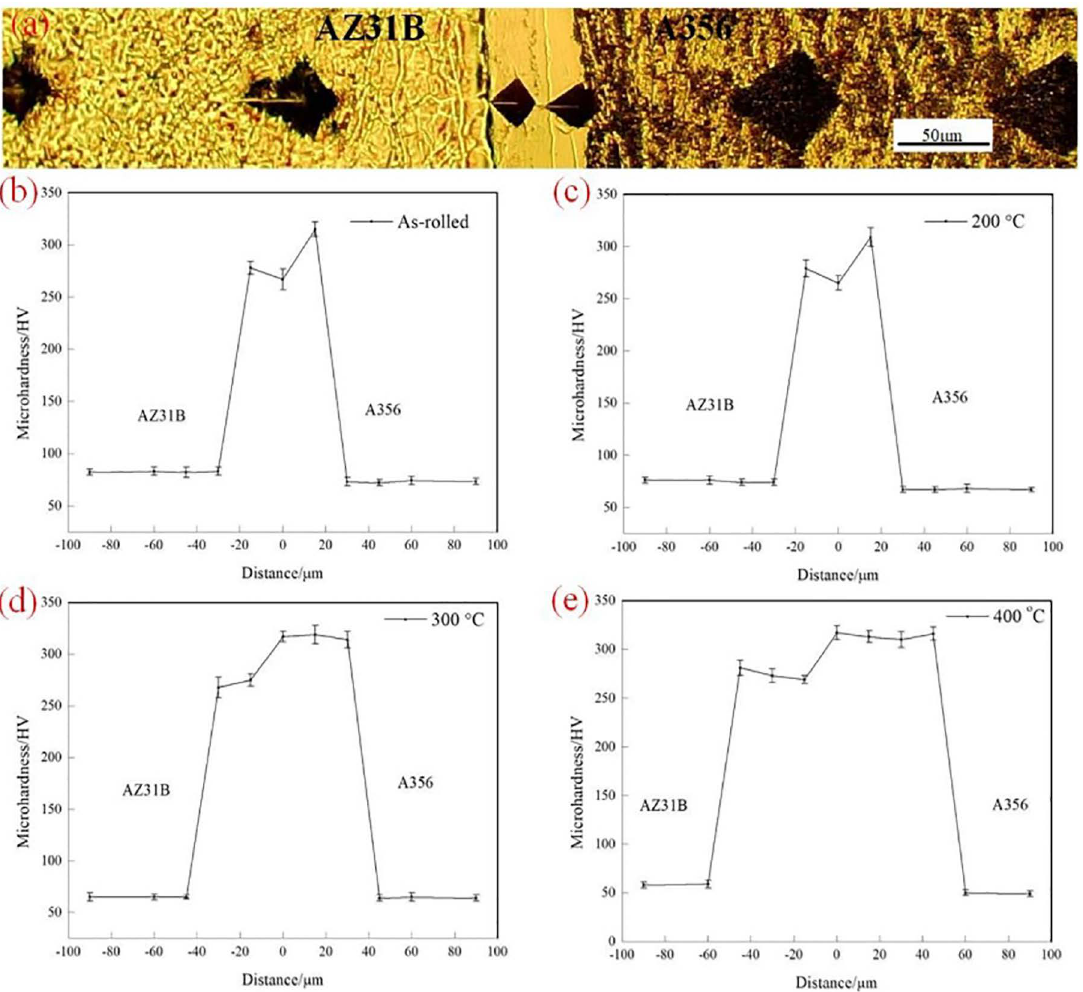
Figure 10. Vickers microhardness test results across the interfacial transition zone under different conditions (annealed for 180 min): (a) indentations of 400 ºC; microhardness distribution: (b) as-rolled, (c) 200 ºC, (d) 300 ºC, (e) 400